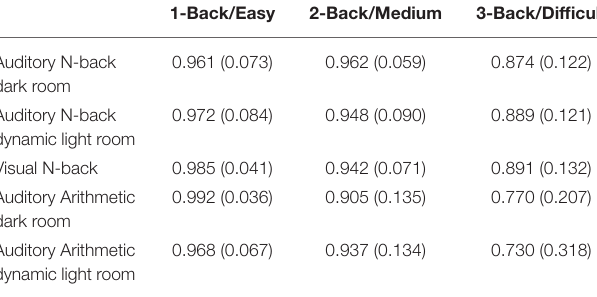
TABLE 1 | Performance of the N-back test in terms of